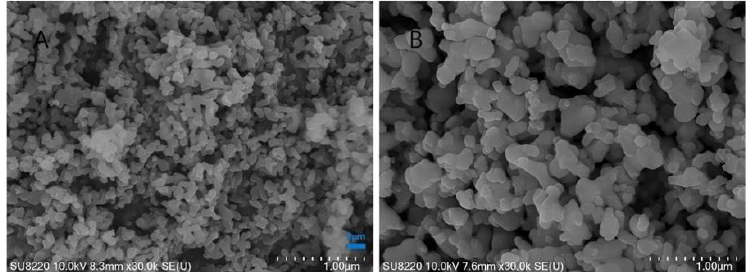
Figure 6. SEM images of porous structures in case of ( A ) untreated and ( B ) CO 2 -treated BCP pow- ders derived from salmon fish bones. Pore dimensions: (0.03–0.15 µm). (Magnification bar: 1 µm). derived from salmon fish bones. Pore dimensions: (0.03–0.15 µ m). (Magnification bar: 1 µ m). Reproduced with permission from [94]. Copyright IOPScience, 2020. Reproduced with permission from [94]. Copyright IOPScience,